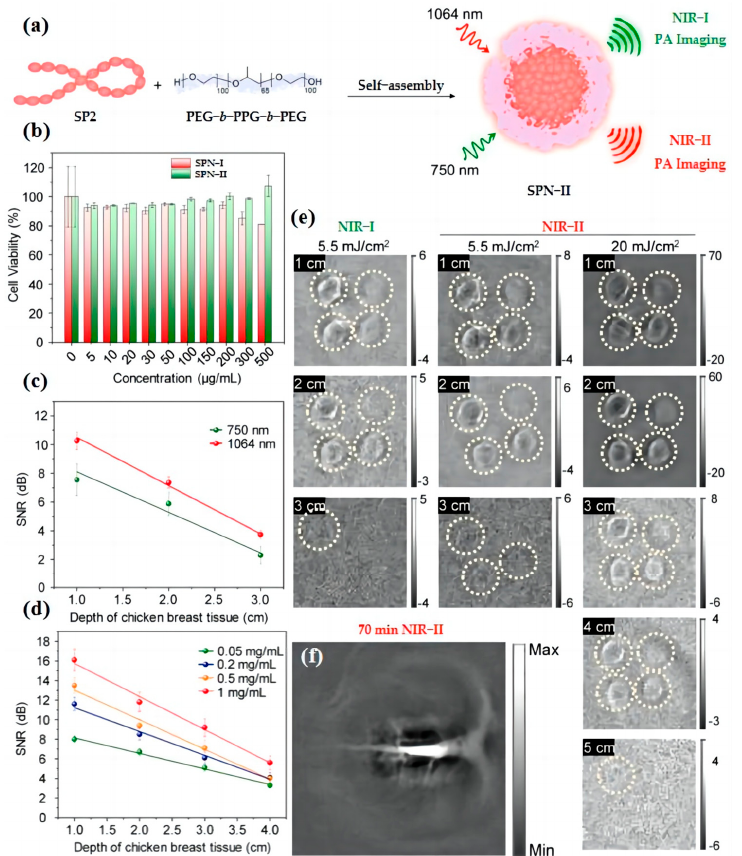
Figure 9. ( a ) Schematic illustration for preparation of SPN-II via nanoprecipitation method. Adapted with permission from [132]. ( b ) Cell viability of NIH/3T3 cells after incubation with SPNs at different concentrations. Adapted with permission from [132]. ( c ) SNR with [SPN-II] = 1 mg/mL at 750 or 1064 nm as a function of the depth of chicken breast tissue. Energy density: 5.5 mJ/cm2, R2 = 0.92549, and 0.99172 for 750 and 1064 nm, respectively. Adapted with permission from [132]. ( d ) SNR with dif- ferent SPN concentrations at 1064 nm as a function of the depth of chicken breast tissue. Energy density: 20 mJ/cm2. R2 = 0.99357, 0.98539, 0.98508, and 0.99005 for 0.05, 0.2, 0.5, and 1 mg/mL, re- spectively. Adapted with permission from [132]. ( e ) Two-dimensional PA images of the agar gel phantom containing SPN-II solutions were acquired in both NIR windows at di ff erent depths. Adapted with permission from [132]. ( f ) PA images of rat cortex at 70 min postinjection of SPN-II at 1064 nm. SPN-II was administered via tail vein injection with a dose of 1.8 mg per rat ( n = 3). Adapted with permission from [132].